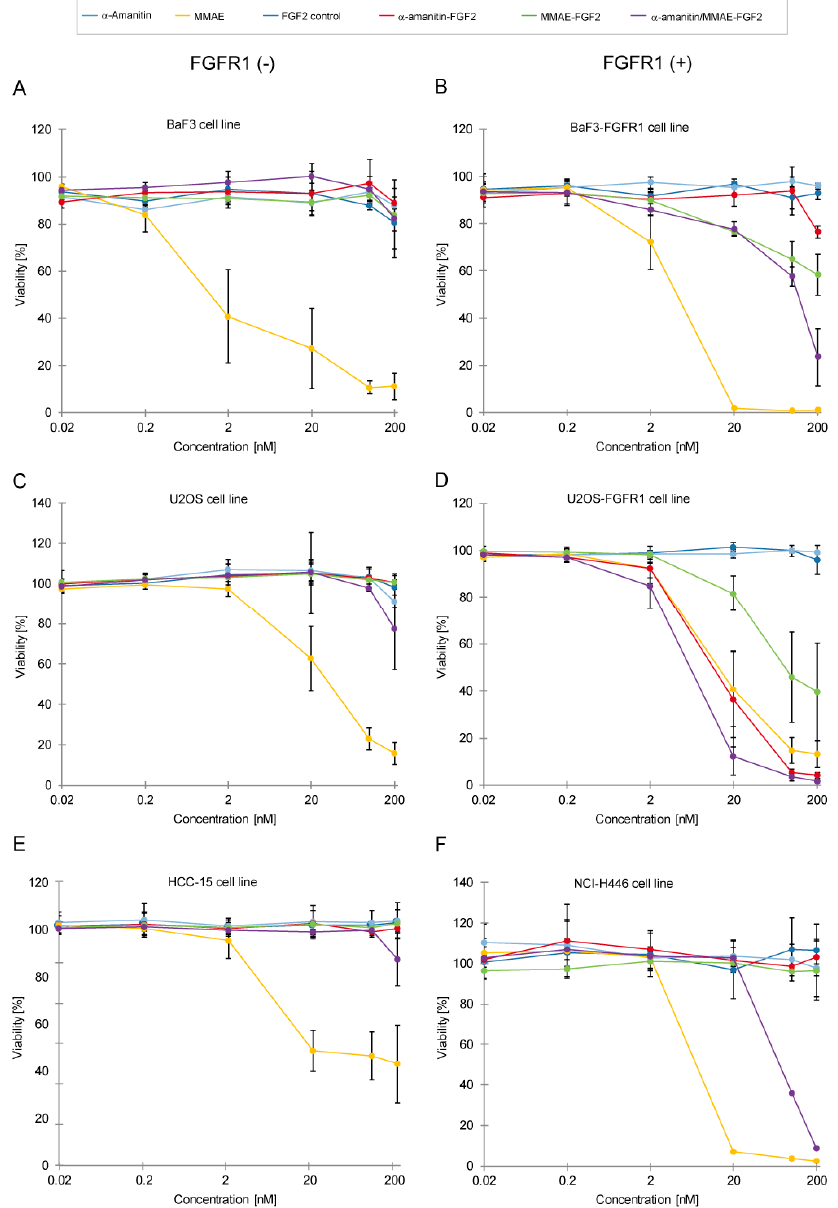
Figure 6. Cytotoxicity tests with FGF2 conjugates in murine pro B and cancer cell lines with different levels of FGFR1 expression. ( A , B ) Cytotoxic effect on BaF3 cells which represent control cell line that does not contain FGFR1 and BaF3-FGFR1 cells stably transfected fgfr1 genes; ( C , D ) Conjugate incubation with osteosarcoma cell lines U2OS (FGFR1-negative) and U2OSR1 (FGFR1-positive); ( E , F ) Cytotoxic tests with FGF2 conjugates on lung cancer cell lines NCI-H446 expressing FGFR1 or FGFR1-negative HCC-15. Error bars represent standard deviation (SD) for n = 3 experiments.